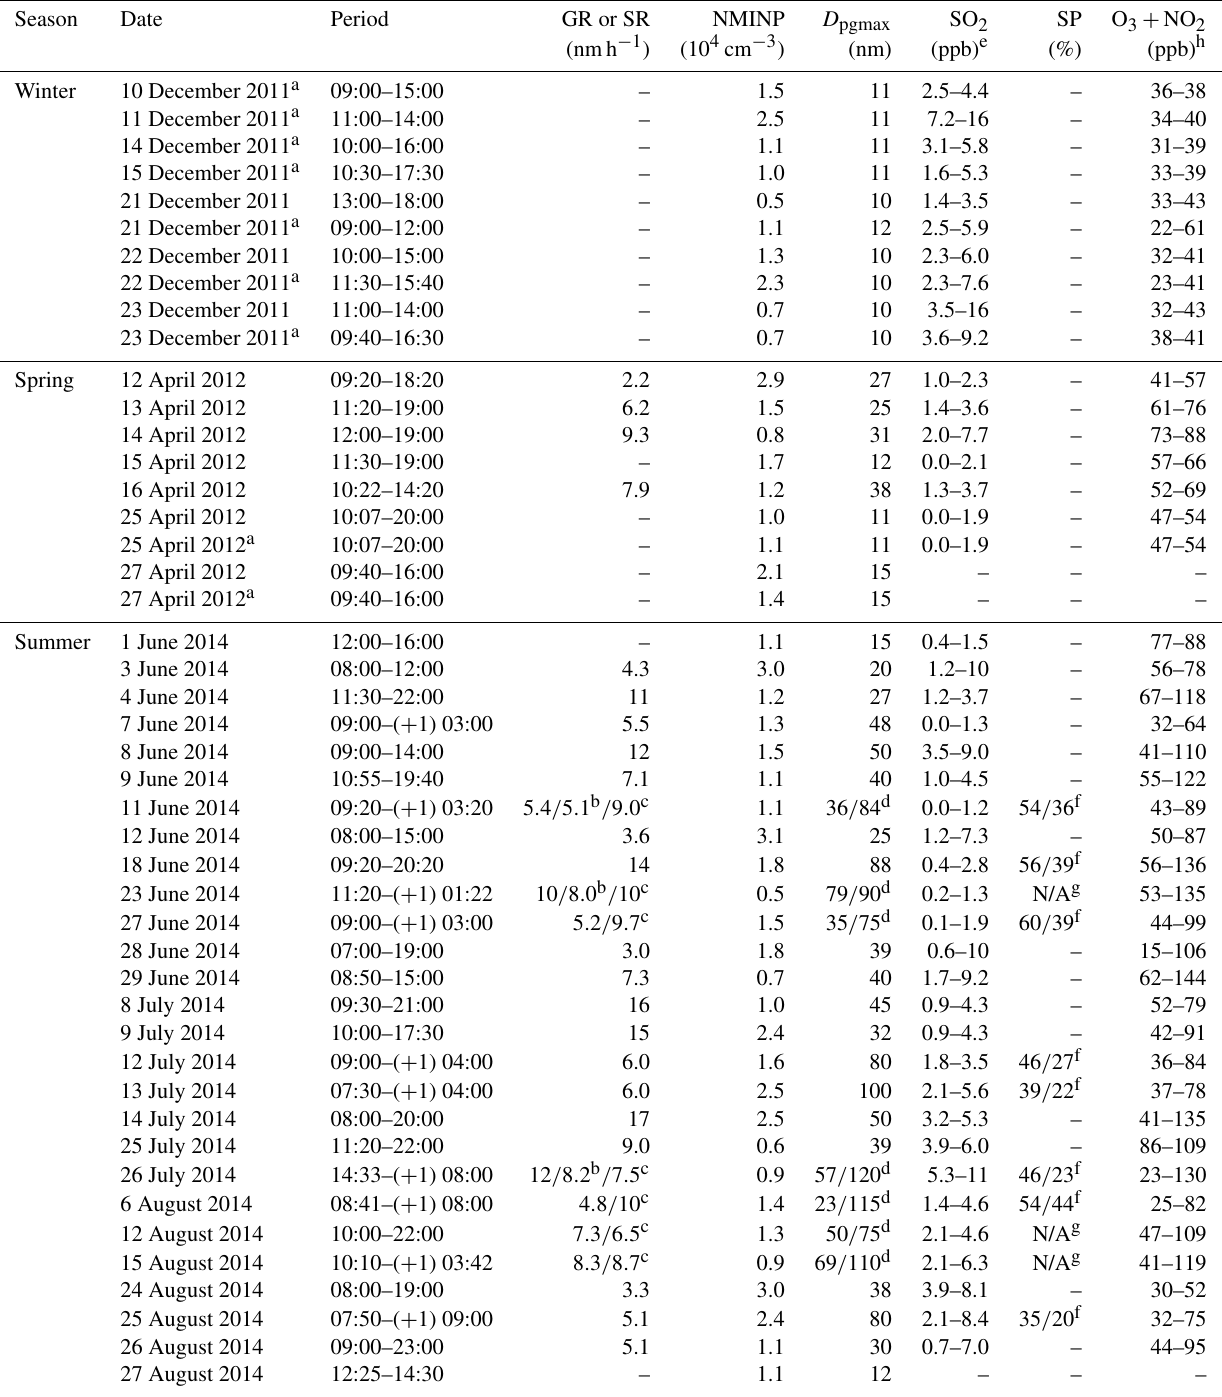
Table 1. Characteristics of NPF events in